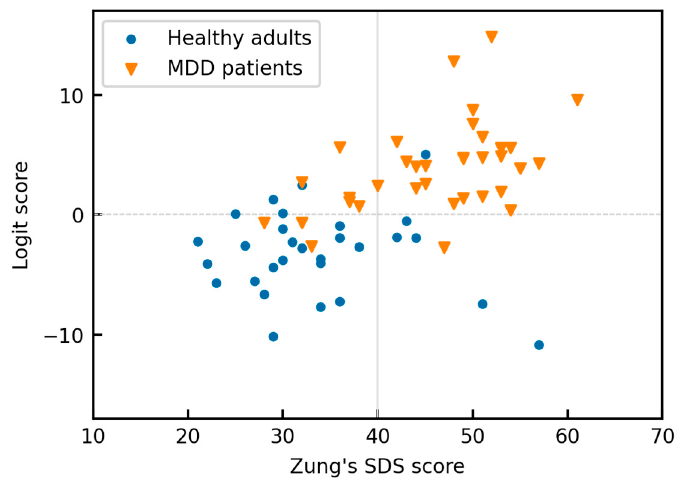
Figure 6. Scatterplot of the Zung Self-Rated Depression Scale (SDS) scores against the logit scores obtained using the proposed algorithm.